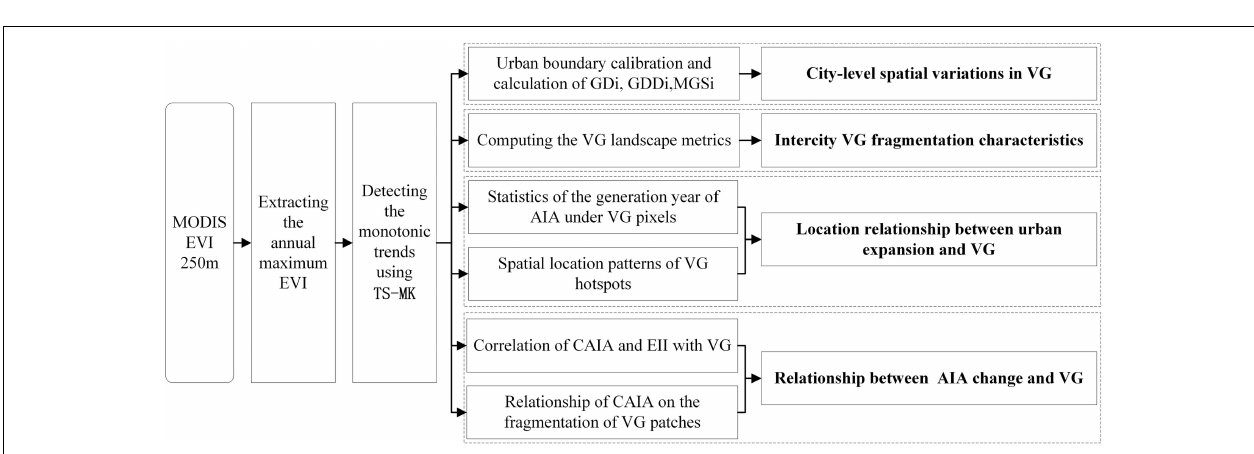
FIGURE 2 | Flowchart for the data processing and analysis used in this